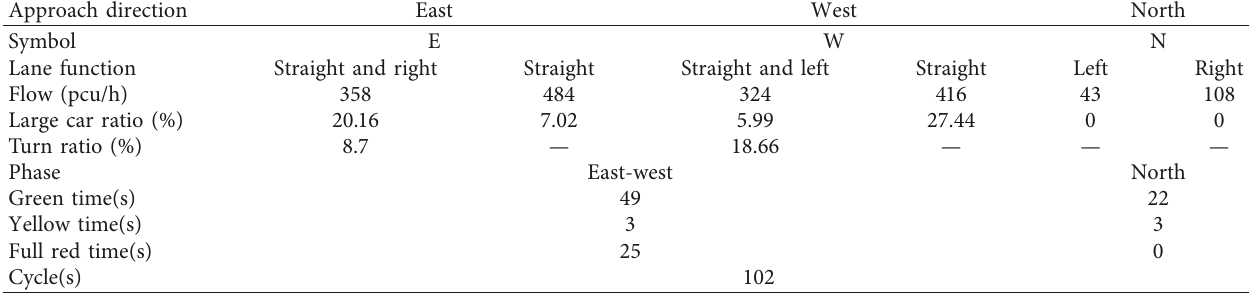
Table 3: Traffic flow and signal timing parameters at the intersection of Wushan road and Yuehan road.